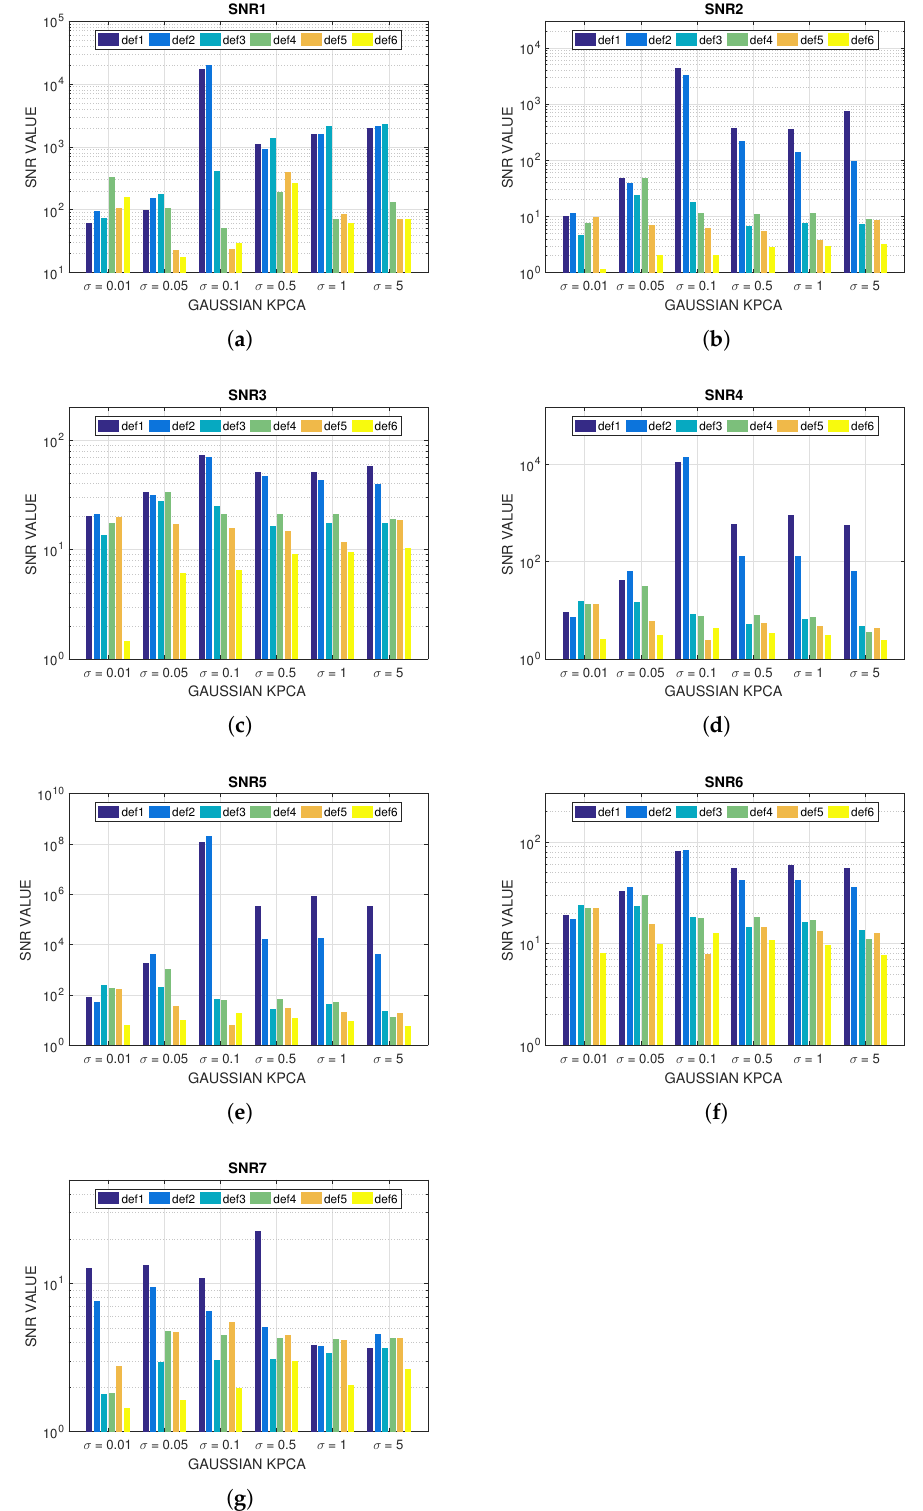
Figure 13. Maximum SNR values obtained with Gaussian KPCA dimensionality reduction technique applied with different variance values: ( a ) SNR1, ( b ) SNR2, ( c ) SNR3, ( d ) SNR4, ( e ) SNR5, ( f ) SNR6, ( g )